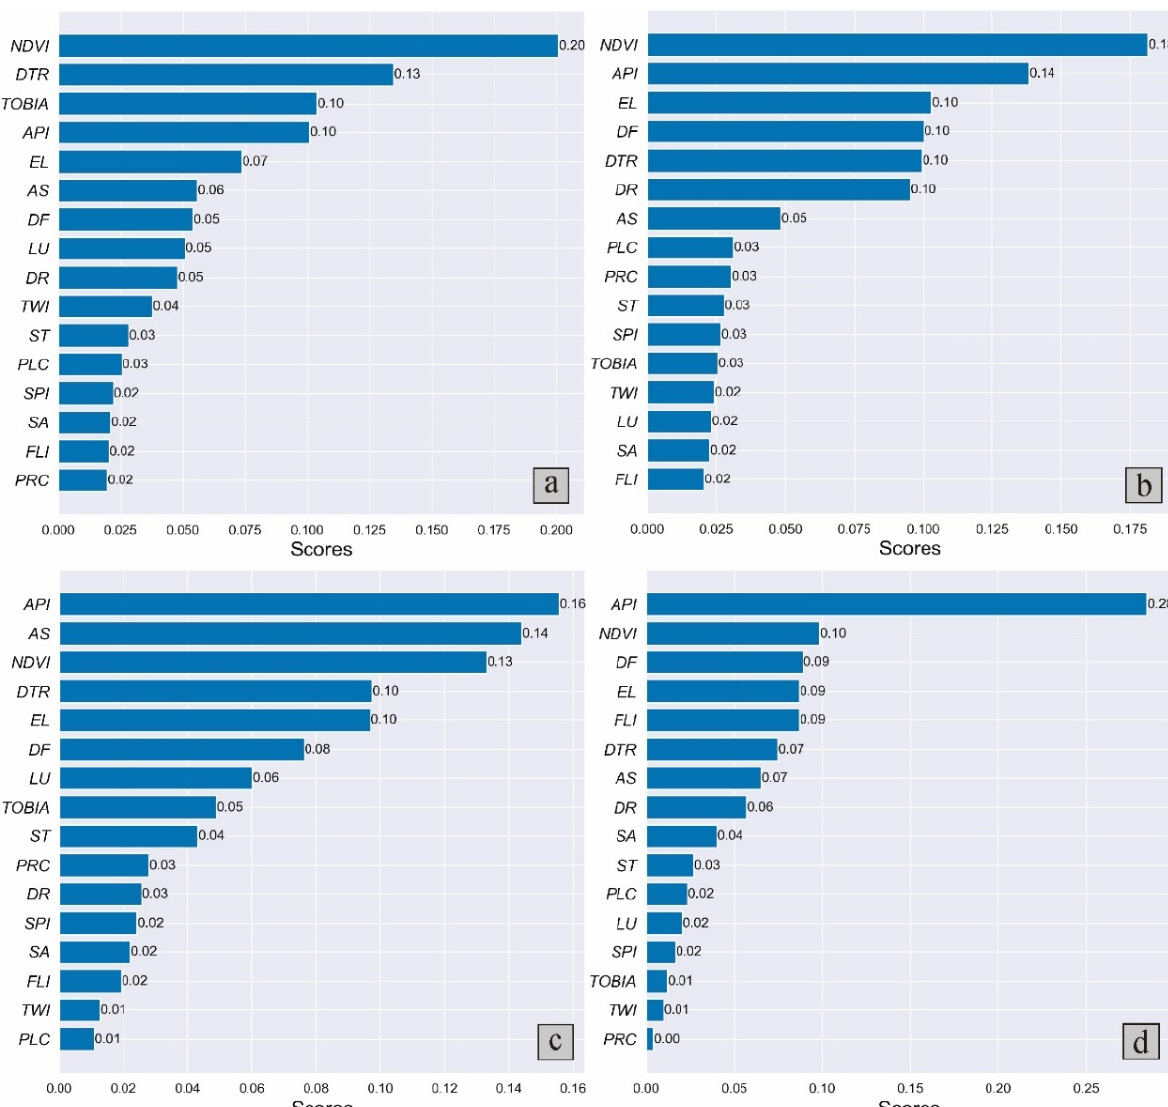
Figure 8. Correlation of the parameters. ( a ) Unclassified database. ( b ) Classification by relative age. ( c ) Classification by size. ( d ) Classification by type of movement.